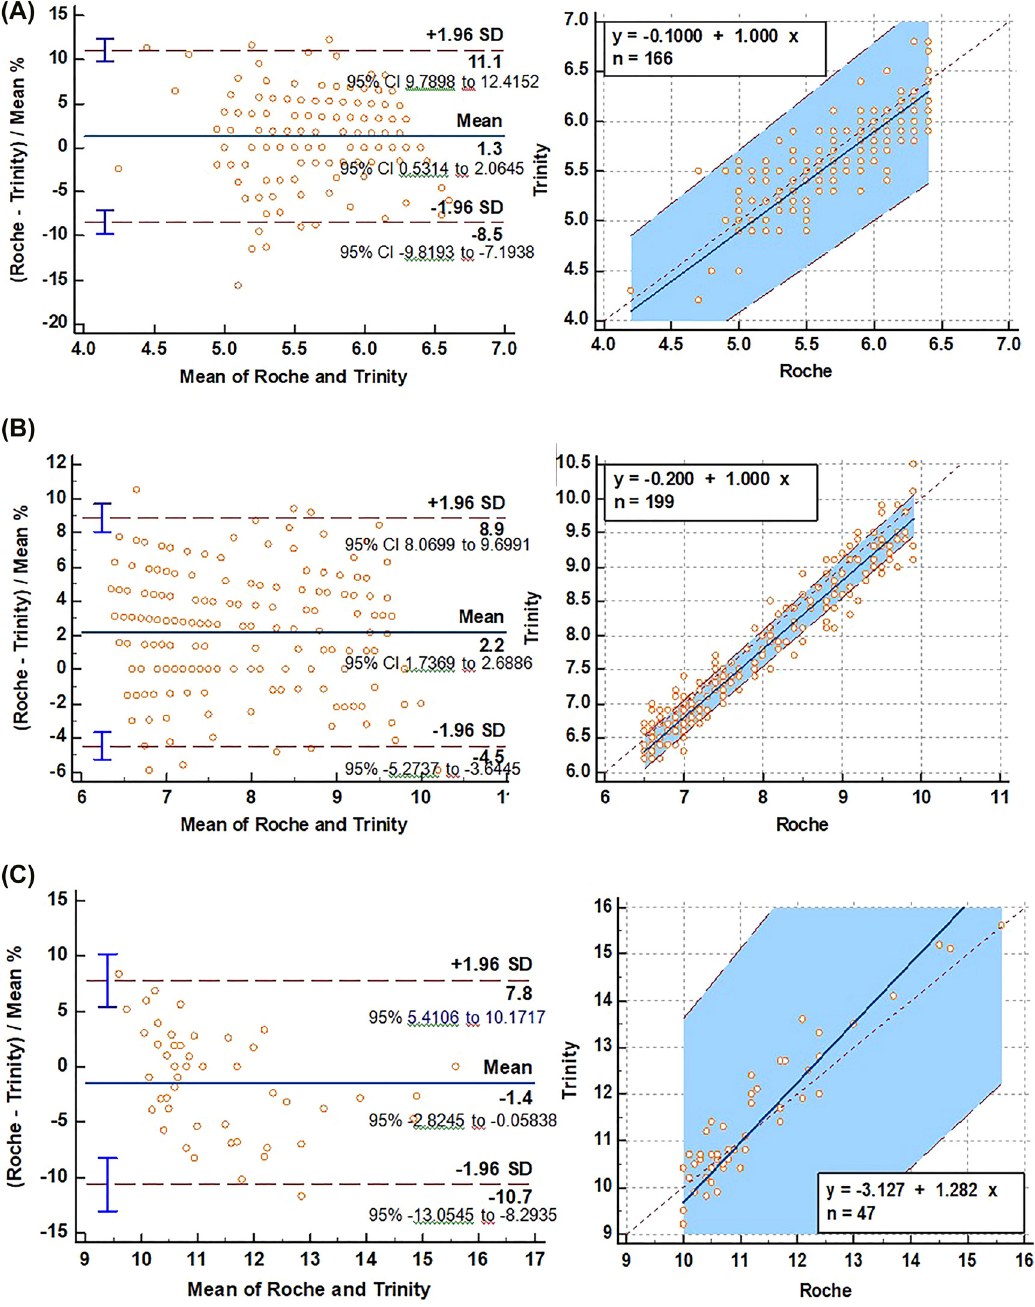
Figure 2: Bland-Altman plot examination for calculating absolute differences between methods for <6.5% (A), 6.5 – 9.9% (B) and ≥ 10% (C) HbA 1c